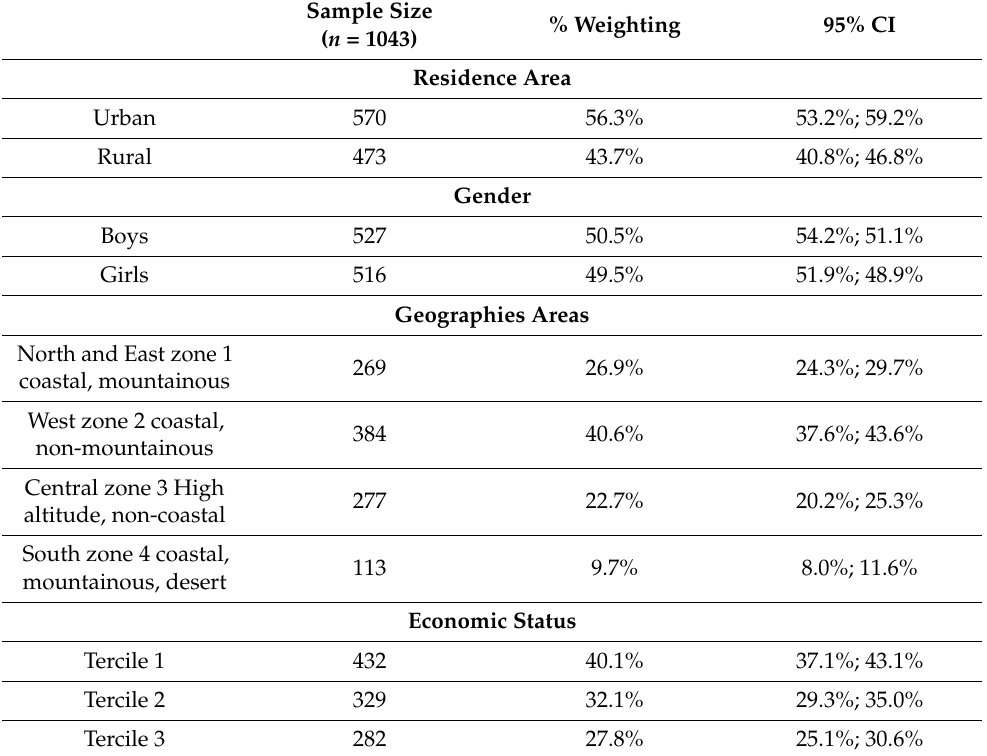
Table 1. Socio-demographic characteristics of the studied population.